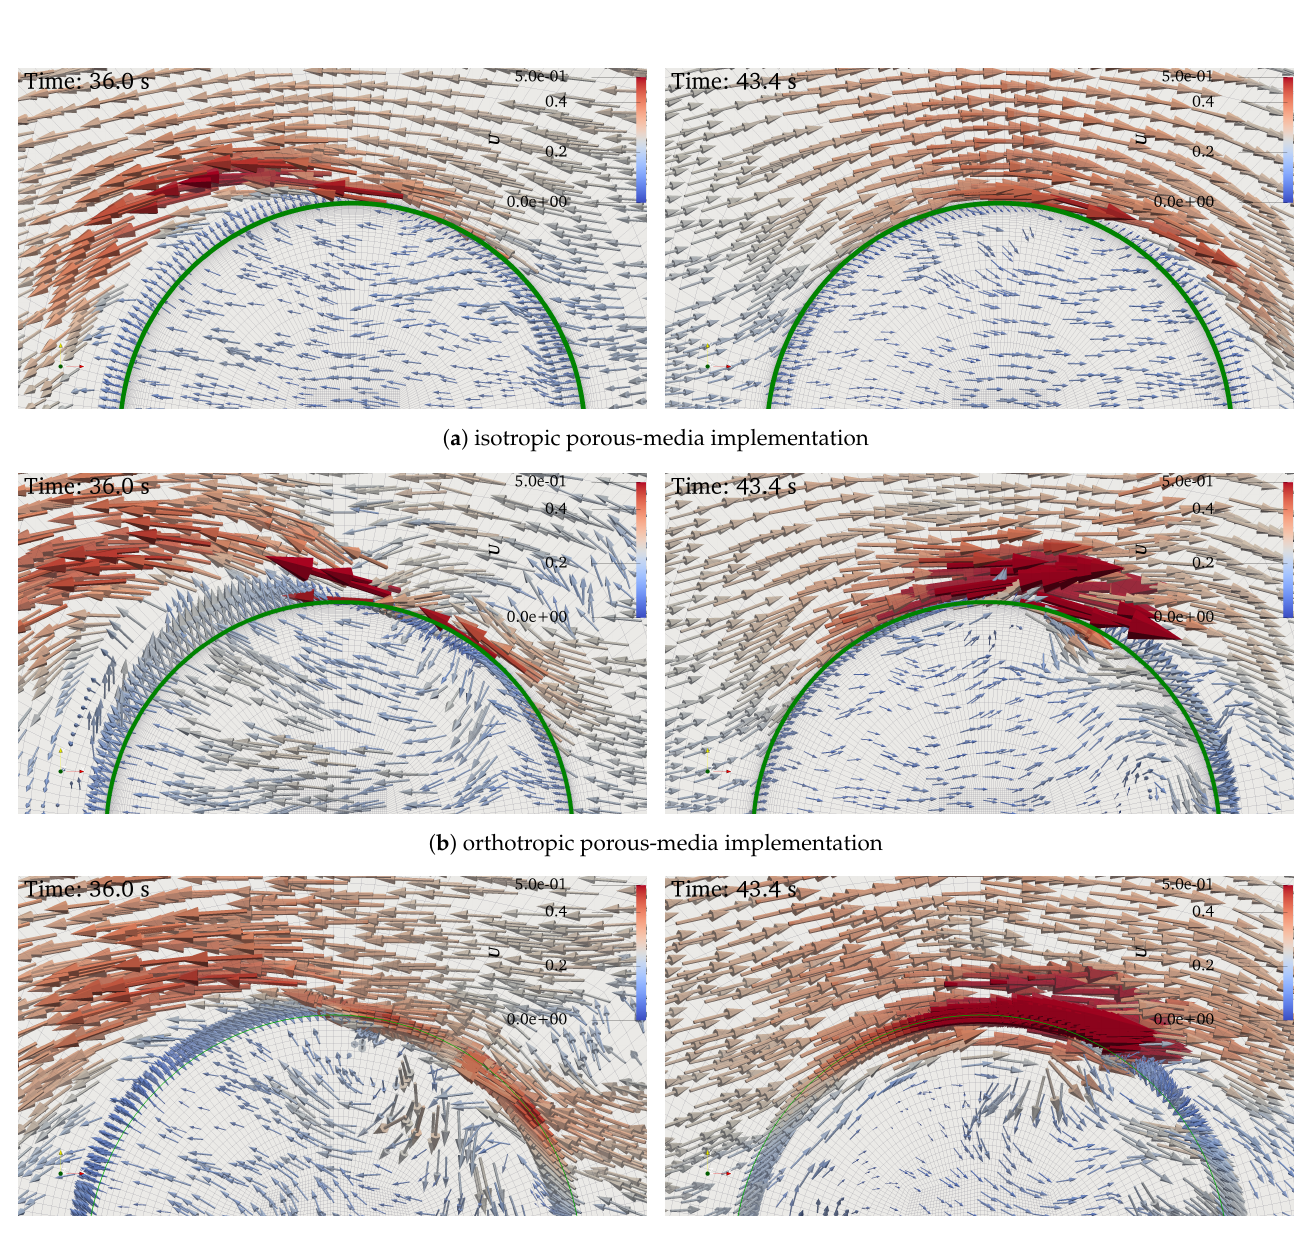
Figure 14. Velocity vectors for two points in time, t = 36.0 s at a wave trough (on the left) and t = 43.4 s at a wave crest (on the right) at the cylinder center. The waves propagate from the left to the right. The velocity magnitude and color of the vectors respectively ranges between 0.0–0.5 m/s. ( a ) isotropic porous-media implementation ( b ) orthotropic porous-media implementation ( c ) baffle